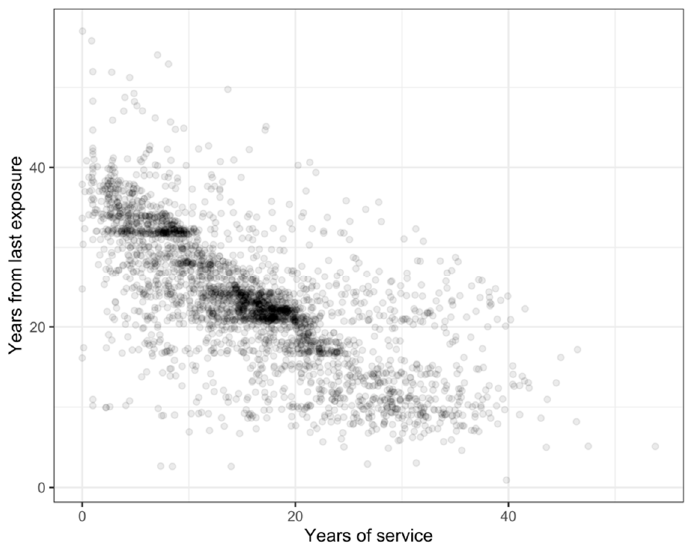
Figure 2. Scatterplot of length of service against time since last exposure.